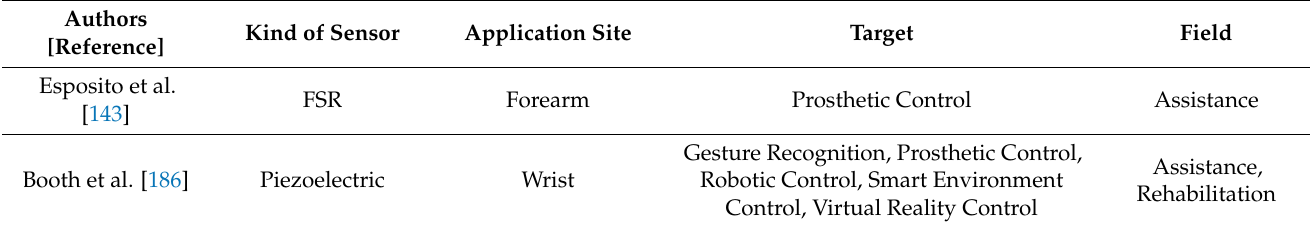
Table 10. Hybrid muscle mechanical motion-based